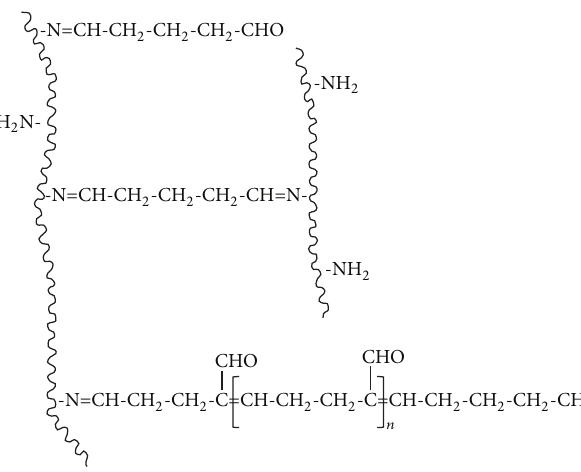
Figure 1: Schematic structure of the glutaraldehyde (GA) cross-linked soy